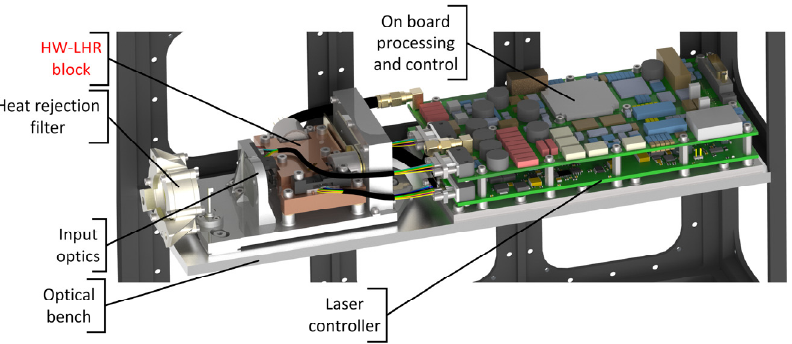
Figure 3. Three-dimensional CAD model of the HIROS instrument. The hollow waveguide integrated LHR block is indicated in red. The volume envelope of the instrument is 10 × 5 × 30 cm 3 .